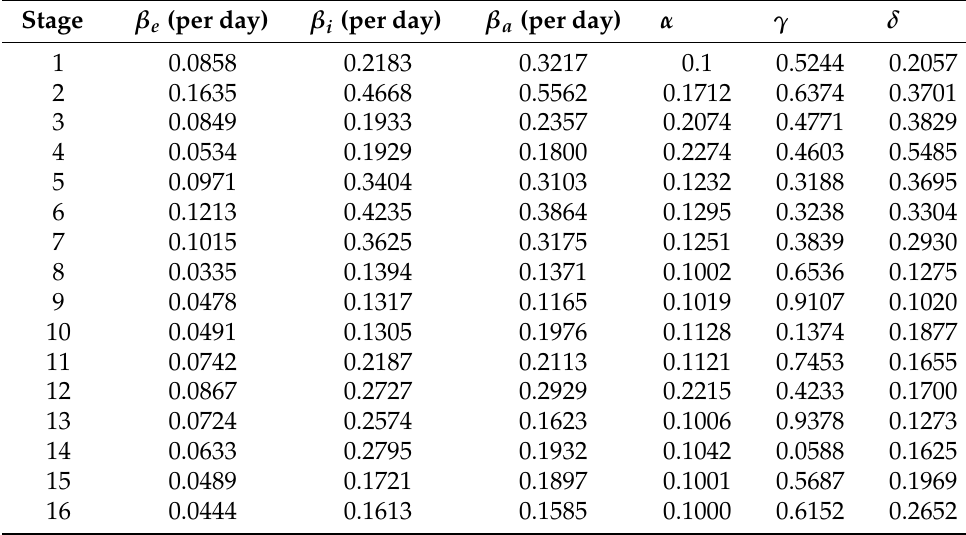
Table 2. Parameters in different stages fitted by the